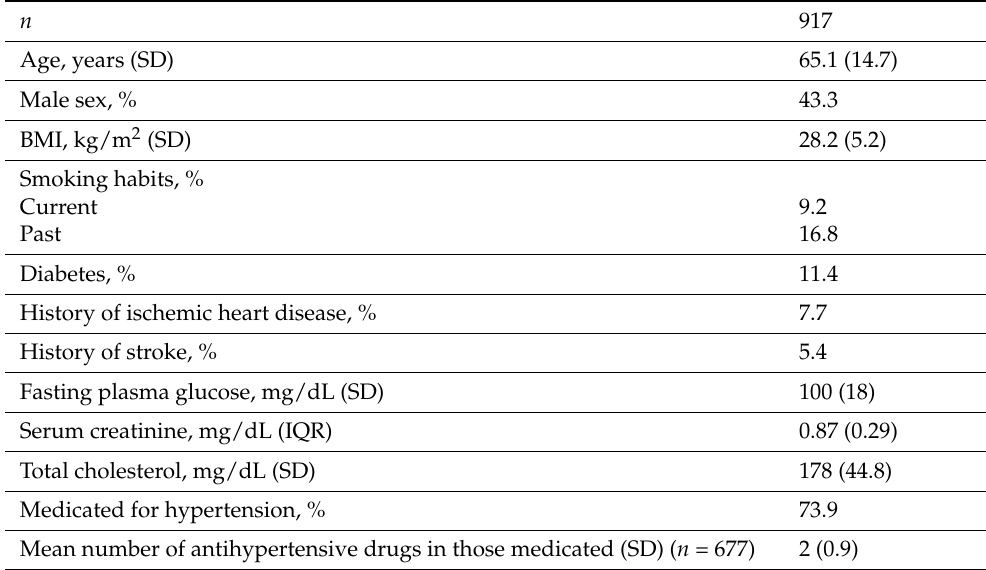
Table 1. Baseline characteristics of study population.